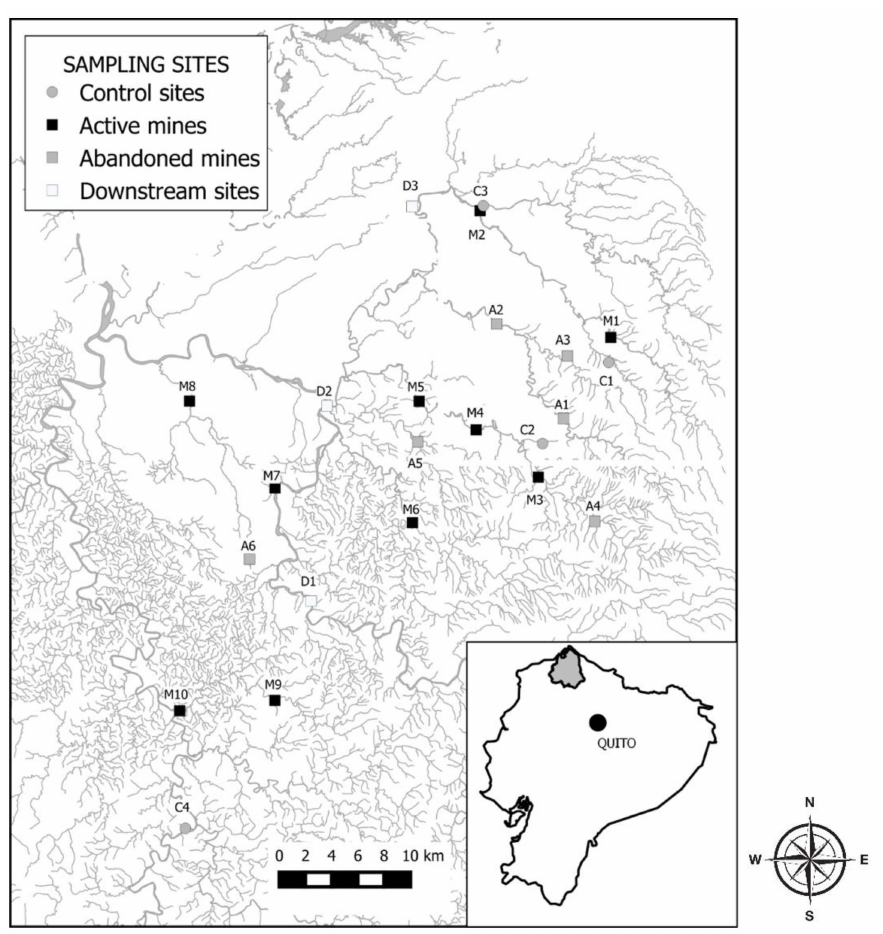
Figure 1. Location of the Santiago-Cayapas watershed within Ecuador and study sites (C, control sites; M, active mines; A, abandoned mines; D, downstream sites). Table 1. UTM Coordinates of Location (WGS84, 17N) and characteristics of sampling